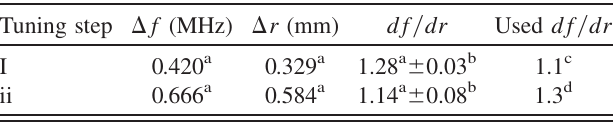
TABLE VI. Coefficient df=dr ( MHz = mm ) for the accelerat- ing cell.